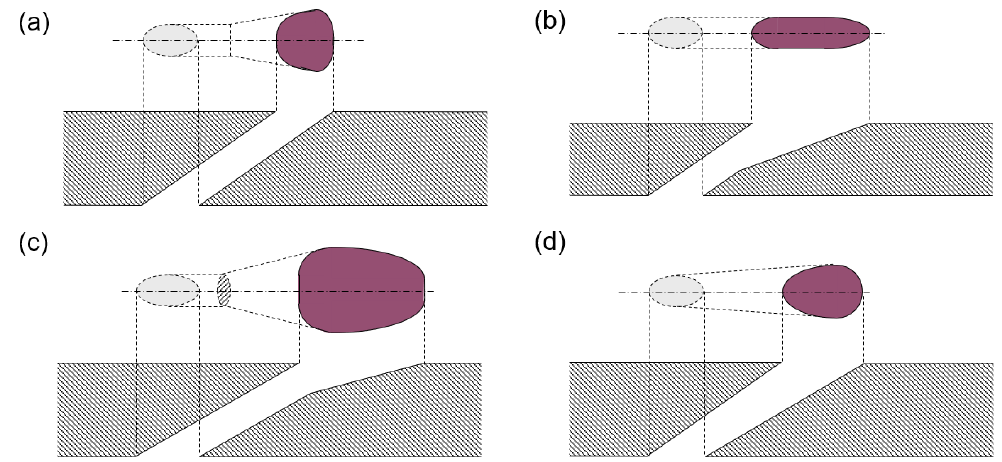
Figure 6. Various expansion types of shaped holes: ( a ) lateral expansion [110], ( b ) forward expan- sion [111], ( c ) forward-lateral expansion [112], and ( d ) conical expansion [113].